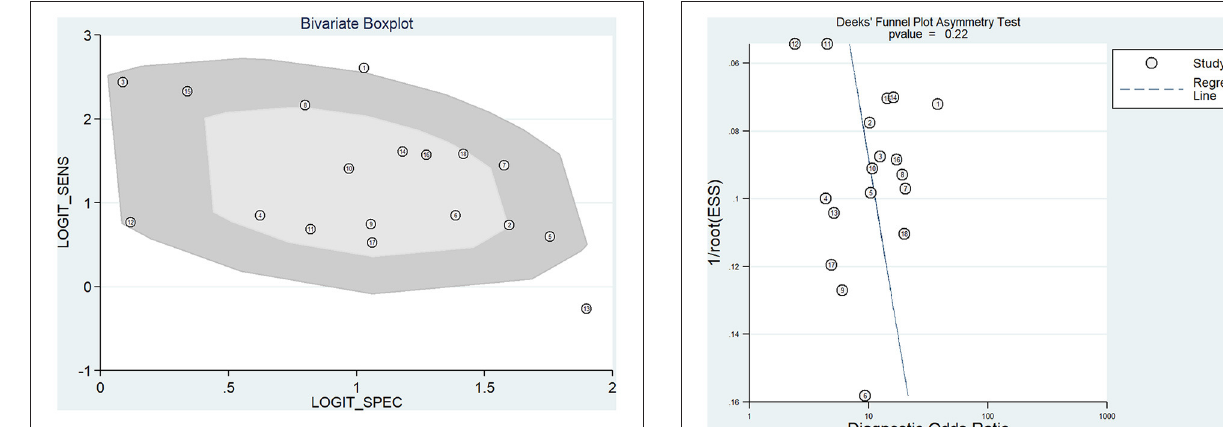
operating characteristics (sROC) curve ( Figure 6F ), with a 95% CI, for the upregulated circRNA group were 0.81 (0.72–0.88), 0.75 (0.67–0.82), 13.20 (8.46–20.57), 3.27 (2.56– 4.16), 0.25 (0.17–0.37), and 0.84 (0.81–0.87), respectively, pooled sensitivity ( Figure 7A ), specificity ( Figure 7B ), DOR ( Figure 7C ), PLR ( Figure 7D ), NLR ( Figure 7E ), and AUC of the sROC curve ( Figure 7F ), with a 95% CI, for the downregulated group were 0.75 (0.66– 0.82), 0.72 (0.65–0.78), 7.74 (4.81–12.45), 2.70